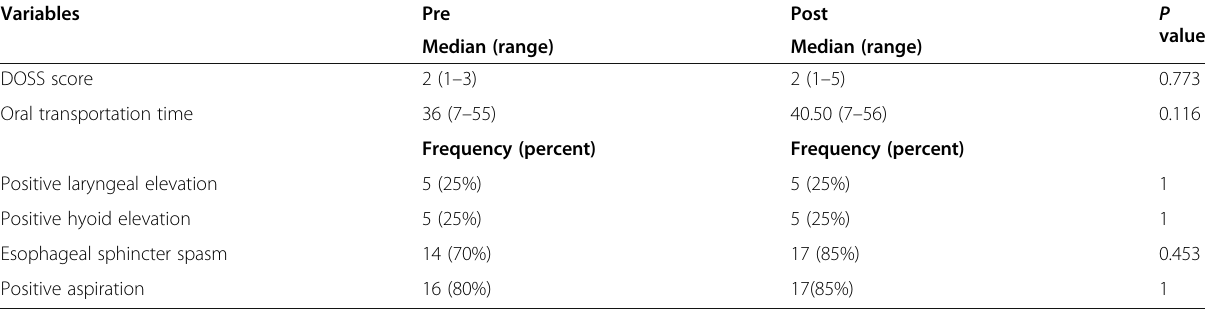
Table 3 Comparison of the DOSS score and different components of the digital fluoroscopic evaluation between pre- and post- treatment in group B Variables